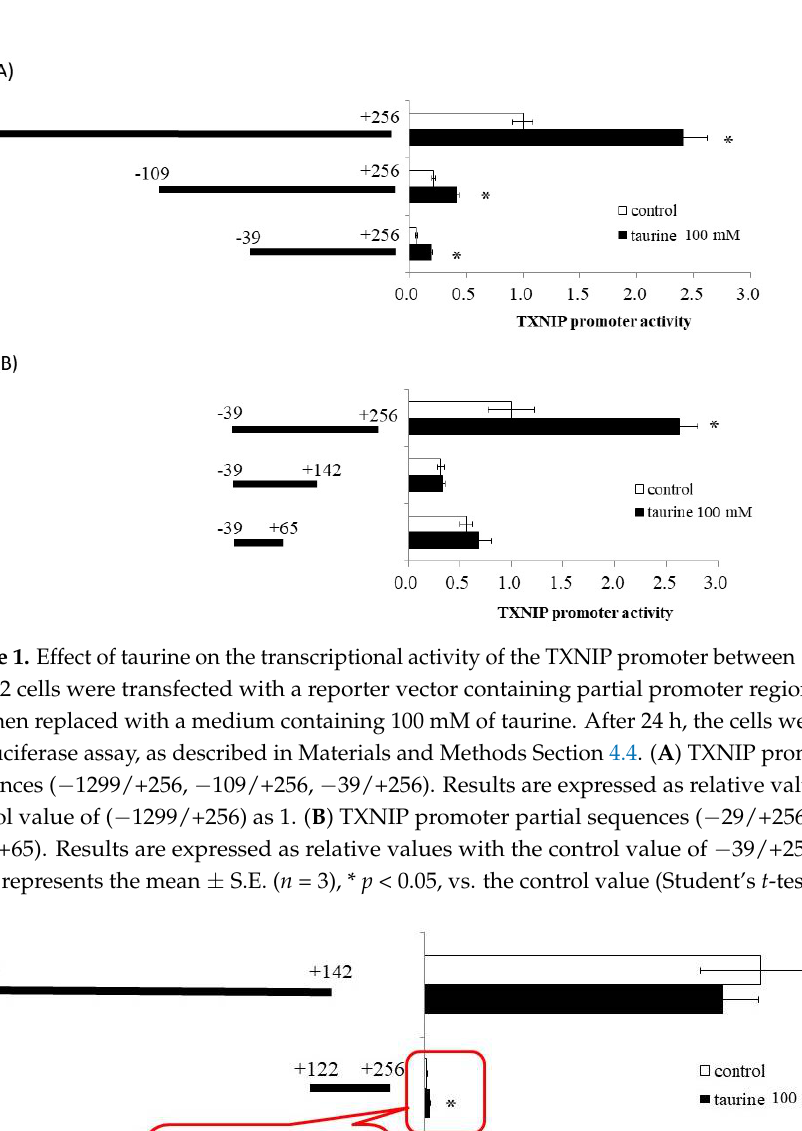
Figure 2. Effect of taurine on the transcriptional activity of the TXNIP promoter containing −1299/+142 and +122/+256. Caco-2 cells were transfected with a reporter vector containing partial promoter region of TXNIP (−1299/+142, +122/+256) and then replaced with a medium containing 100 mM of taurine. After 24 h, the cells were subjected to luciferase assay. The results are expressed as relative values, with a control value of +122/+256 as 1. Each value represents the mean ± S.E. ( n = 3), * p < 0.05, vs. the control value (Student’s t -test).